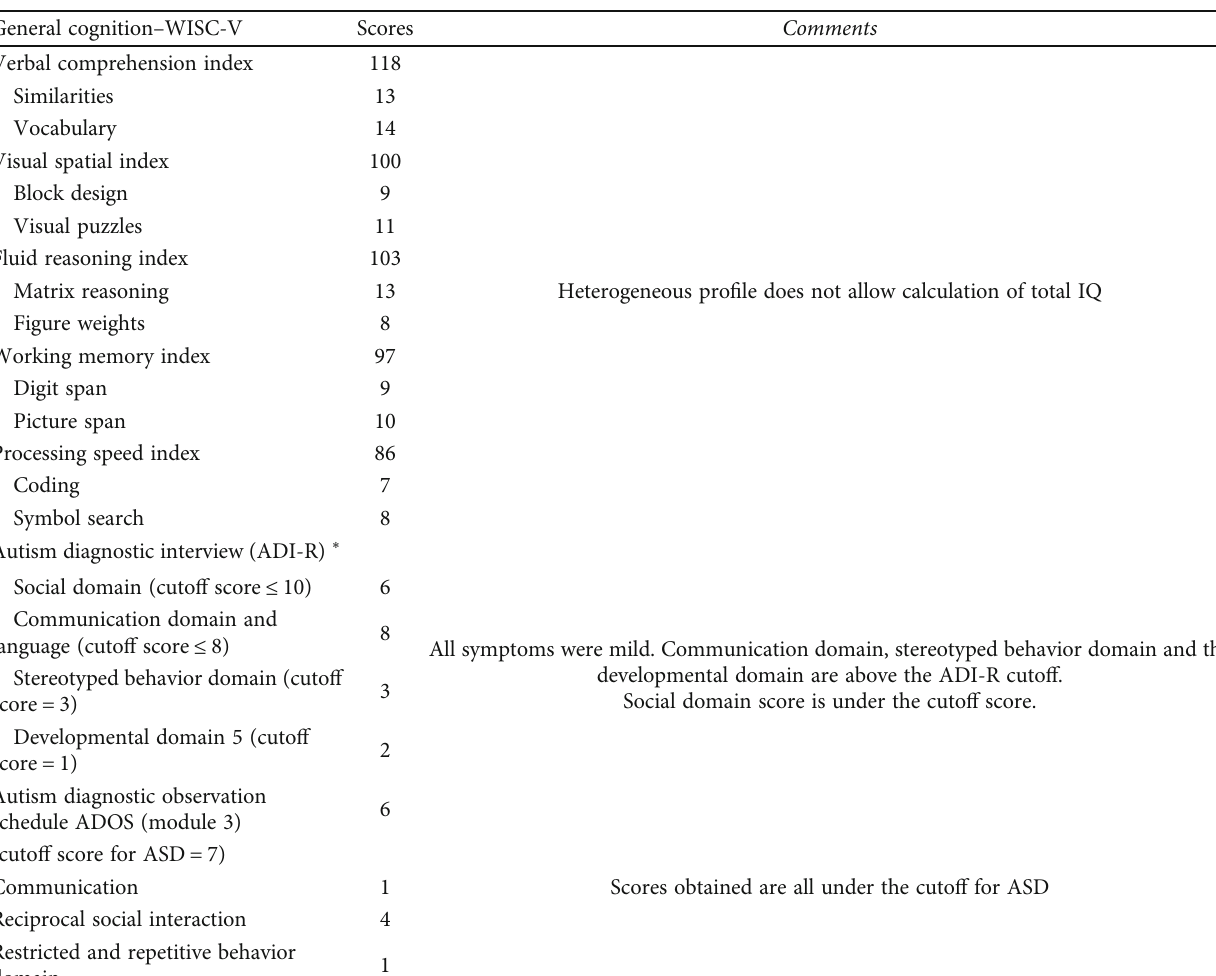
Table 1: Summary of interdisciplinary assessments in 8 years old boy with an atypical autism and an Ehlers – Danlos